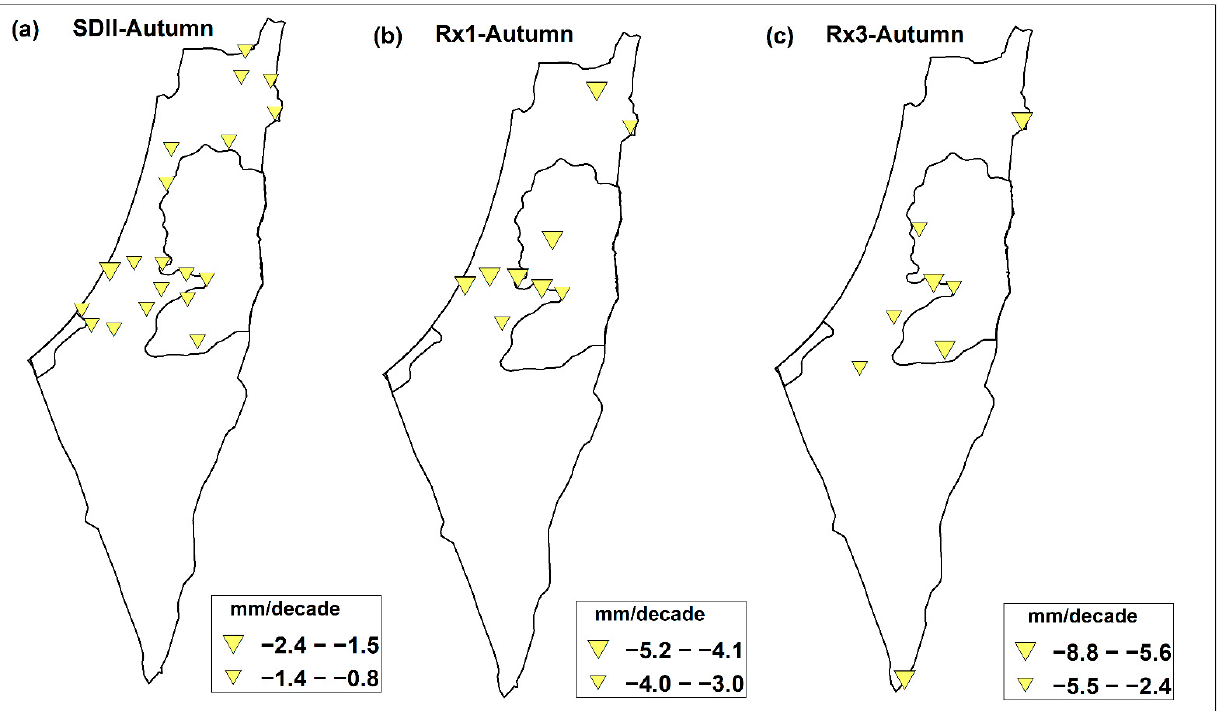
Figure 5. Spatial distribution of autumn trends for some indices that exhibited notably significant decreasing (yellow triangles) or increasing (blue triangles) trends. decreasing (yellow triangles) or increasing (blue triangles)